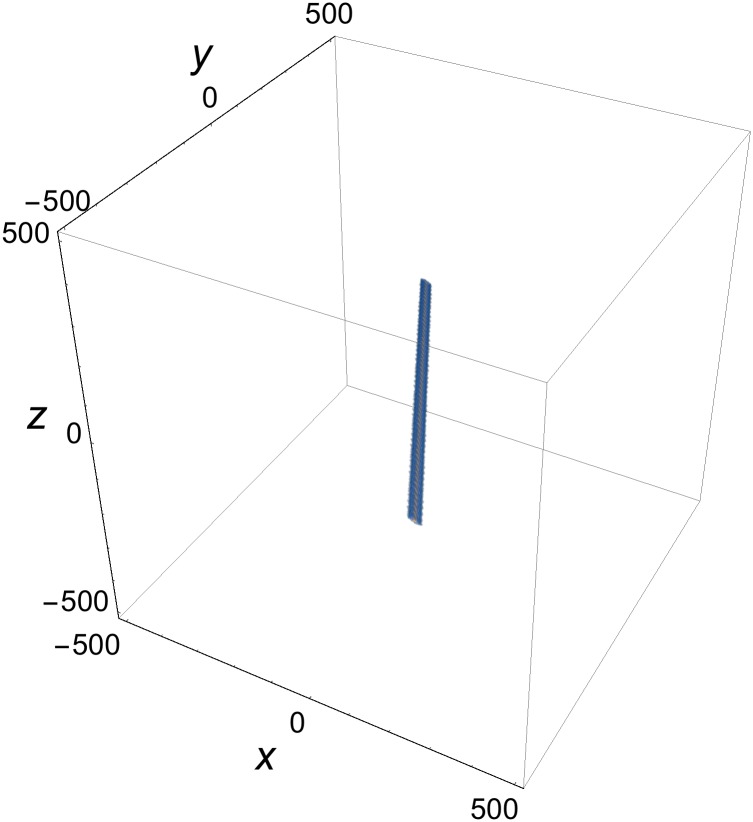
Single-rod solution of Eq (3) at t = 0.p(1) = {1, cosφ(1), sinφ(1), 1}, p(2) = {2, cosφ(2), sinφ(2), 2}; φ(1) = π/5, φ(2) = π/4; δ(1) = δ(2) = 0.